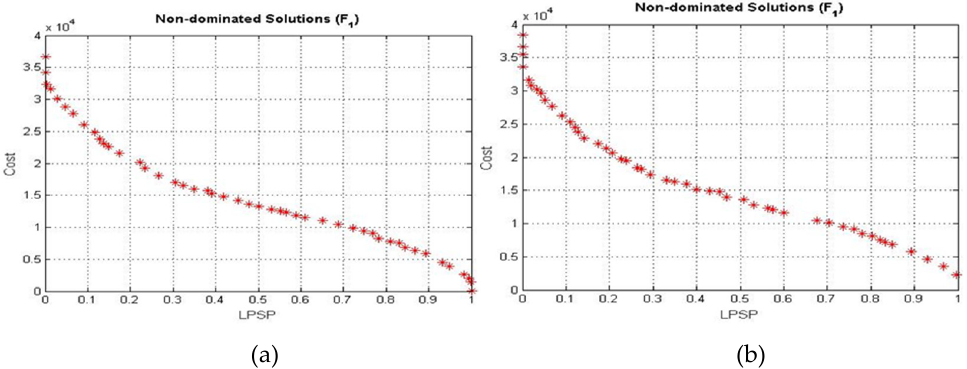
Figure 8. ( a ) Cost versus LPSP graph employing NSGA-GWO Algorithm. ( b ) Cost versus LPSP graph employing NSGA II.